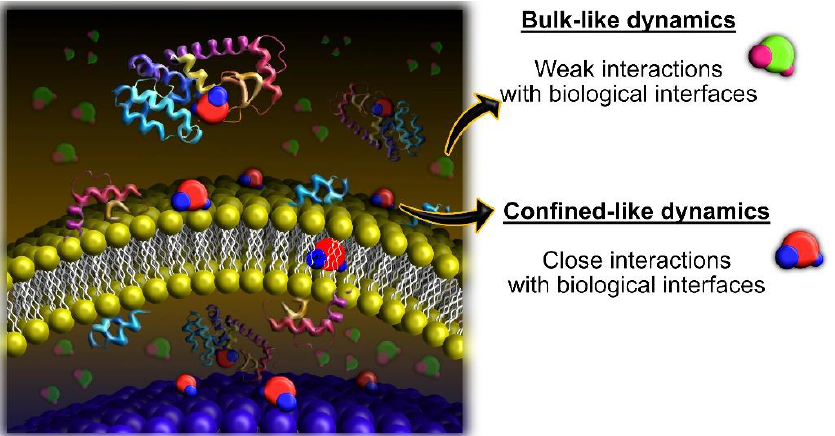
Figure 4. Illustration of the complex chemical environment within living cells and the different water populations. The green/pink molecules depict the bulk-like populations, which are subjected to weak interactions with the biological interfaces and are more abundant in cellular media (they are semi-transparent in the figure for presentation purposes). The red/blue molecules depict the confined-like populations, which are subjected to closer interactions with the biological interfaces and present features of confined dynamics that are not comparable with bulk water.